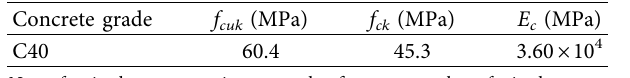
Table 2: Mechanical properties of the concrete.